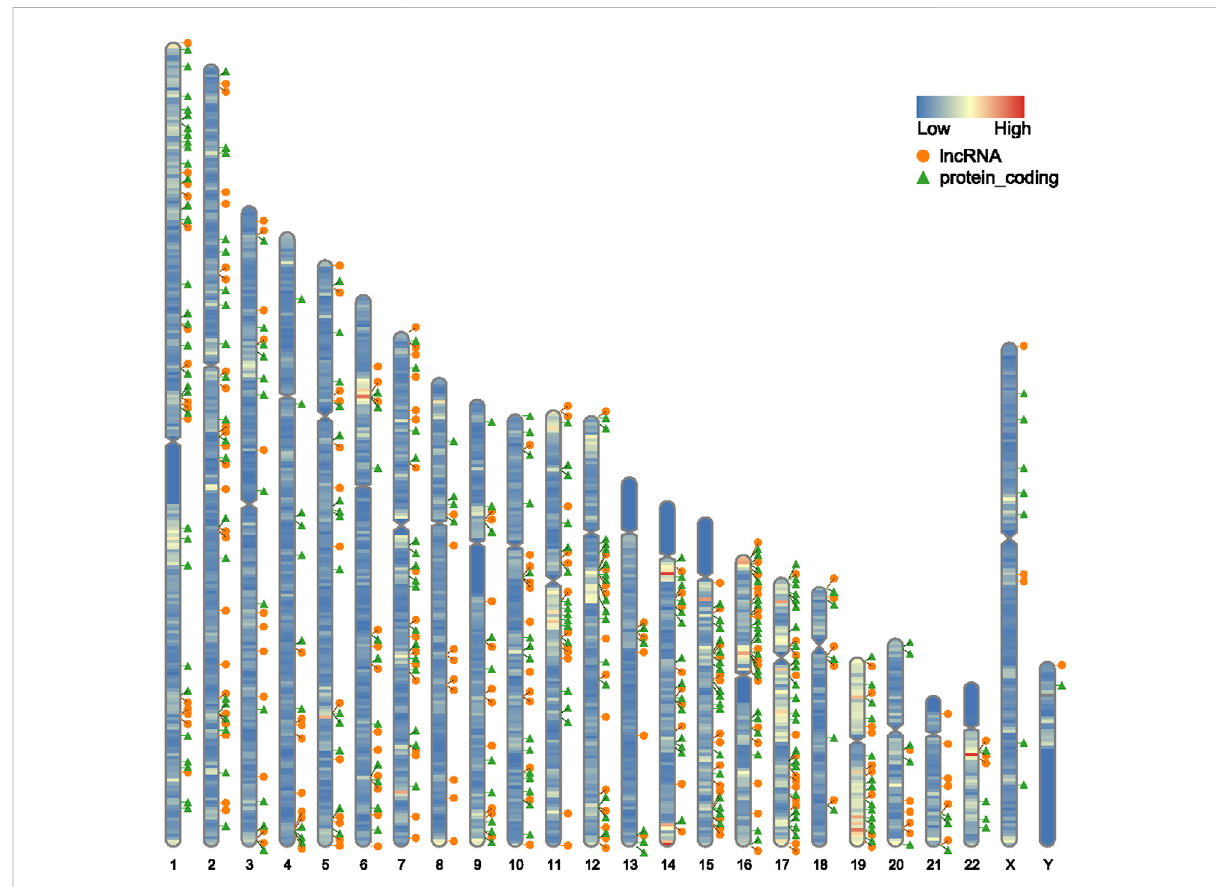
FIGURE 2 SchematicdiagramofthedistributionofdifferentiallyexpressedmRNAandlncRNAonchromosomes, orangecirclesrepresentlncRNAs,green triangles represent protein-coding, and the color on each chromosome represents gene